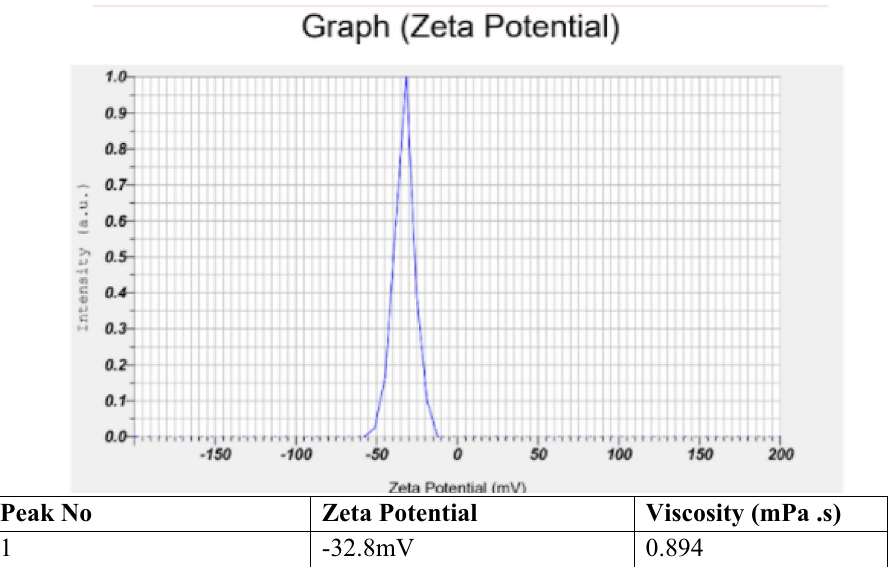
Figure 5. Spidroin’s zeta potential results, which has average value −32.8 mV therefore show a good particle